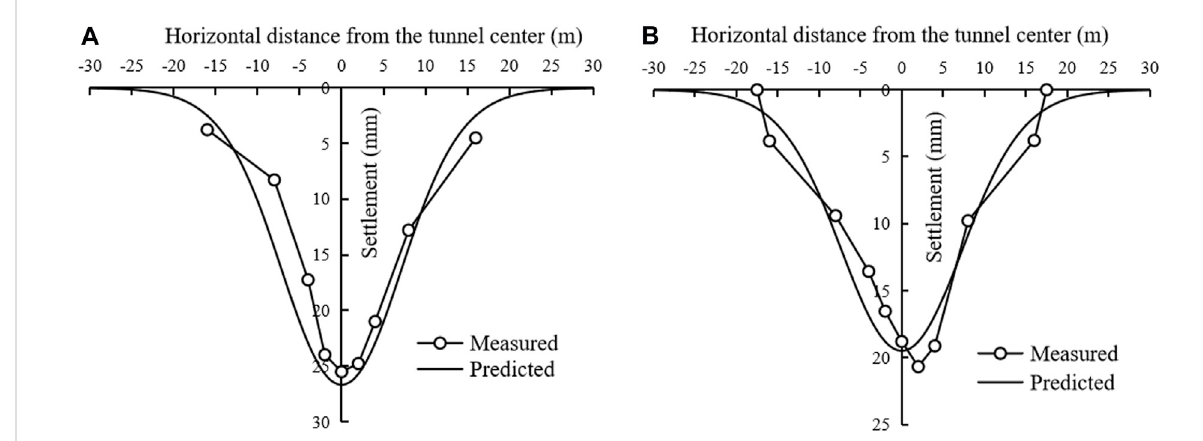
FIGURE 9 Surface settlement induced by DOT shield tunneling: (A) R100; (B)